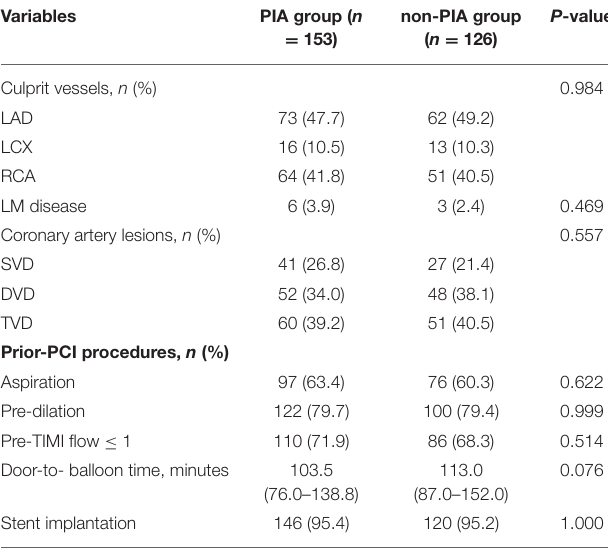
TABLE 1 | Baseline characteristics. TABLE 2 | Angiographic